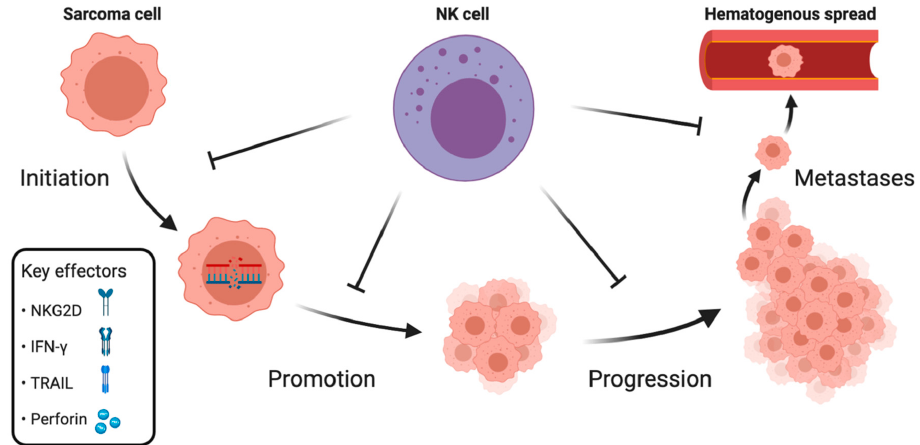
Figure 1. Overview of the central role of natural killer (NK) cells in all stages of sarcoma evolution. Through cell-mediated cytotoxicity, NK cells are able to inhibit tumor initiation, promotion, progression, and development of metastases. The key molecules necessary for NK cell-mediated tumor immunosurveillance are NKG2D, interferon (IFN)- γ , TNF-related apoptosis-inducing